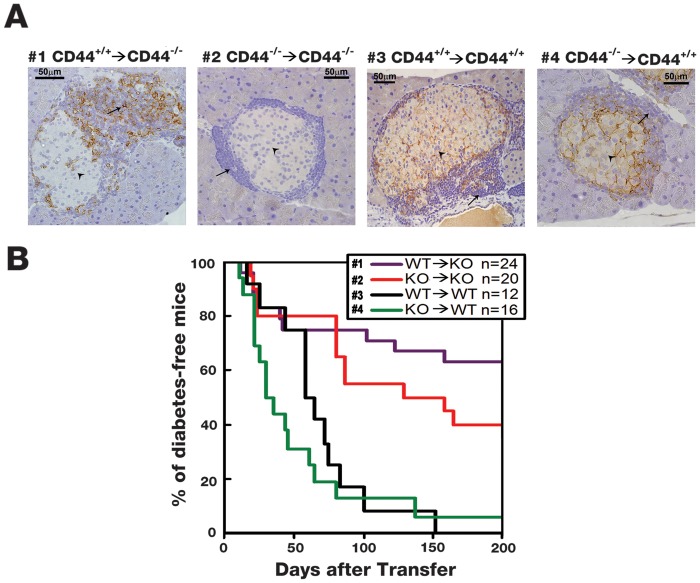
CD44 expressed in the recipient’s tissue rather than on the infiltrating-cells enhances the development of T1D in the cell transfer model.A) CD44-deficient non-diabetic NOD male recipients were reconstituted with inflammatory spleen cells derived from WT (CD44+/+→CD44-/-; marked #1) or CD44-deficient (CD44-/-→CD44-/-; marked #2) diabetic NOD female donors. In addition, WT non-diabetic NOD male recipients were reconstituted with inflammatory spleen cells derived from WT (CD44+/+→CD44+/+; marked #3) or CD44-deficient (CD44-/-→CD44+/+; marked #4) diabetic NOD female donors. Inflammatory cells are marked by arrows and local islet cells by arrowhead. The pancreases of all 4 combinations were removed after detection of diabetes or 200 days after cell transfer. Doing so, pancreases that were harvested approximately at the same time, were stained with anti-CD44 mAb. B) The % of diabetes-free mice (exhibiting less than 250 mg/dL urine glucose) was determined in corresponding four mouse groups, described in A. Statistical analysis by Breslow: #2 versus #3, P < 0.01; #1 versus #2 (follow up 75 to 200 days), P < 0.03; #3 versus #4 (follow up 20 to 75 days), P < 0.03.